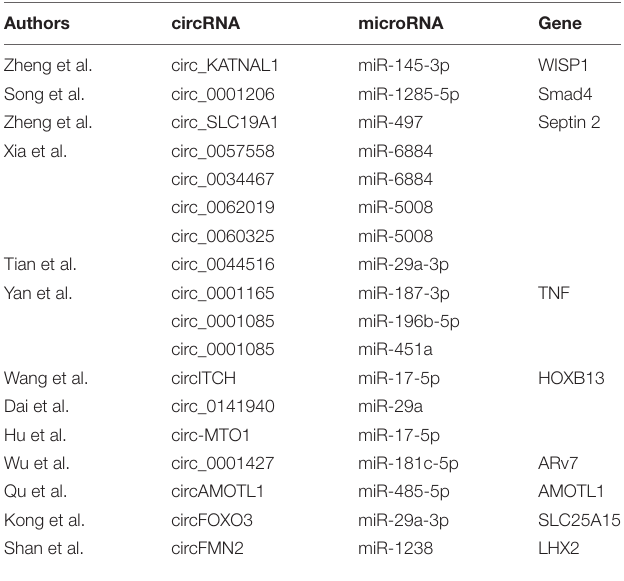
TABLE 3 | PubMed literature review of circRNA–miRNA